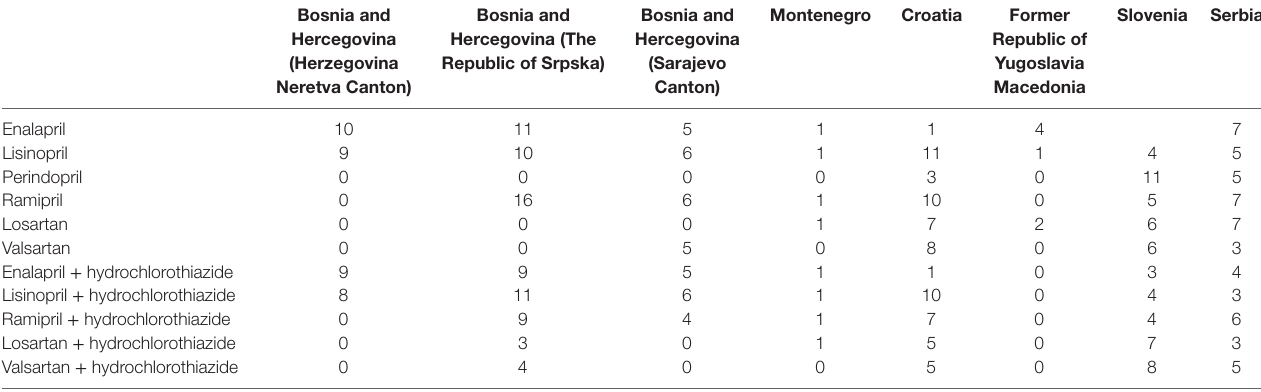
TaBle 3 | Number of ACE and ARB inhibitor parallels; combination of ACE with diuretics, combination of ARB with